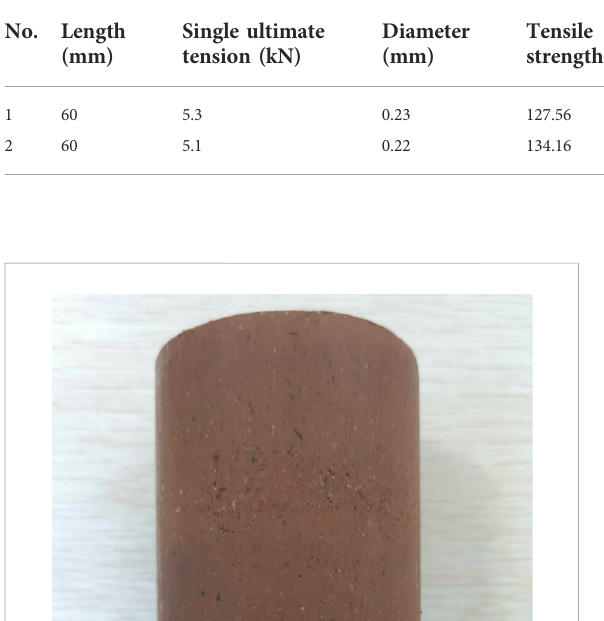
TABLE 1 Performance parameters of coir fi ber.